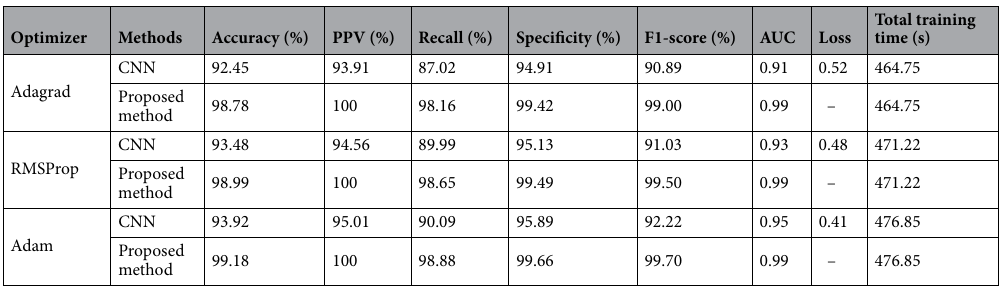
Table 3. Performance comparison between a stand-alone classifier (CNN) and the proposed